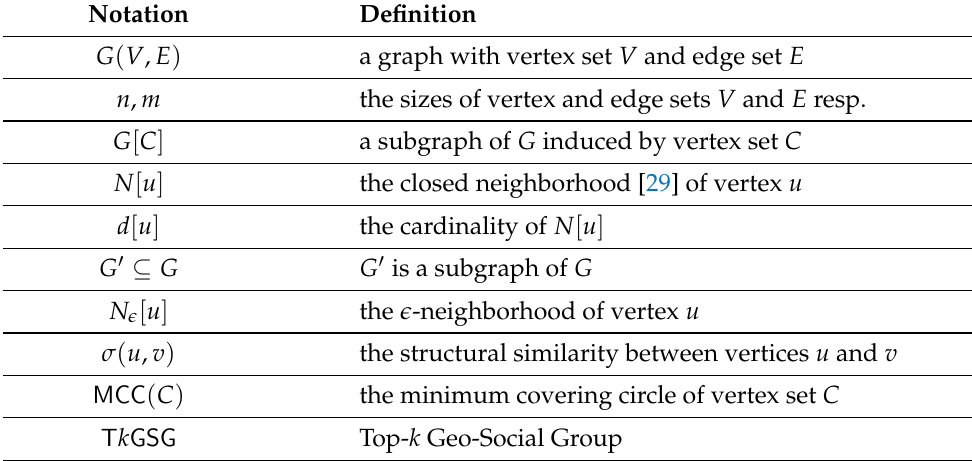
Table 1. The summary of